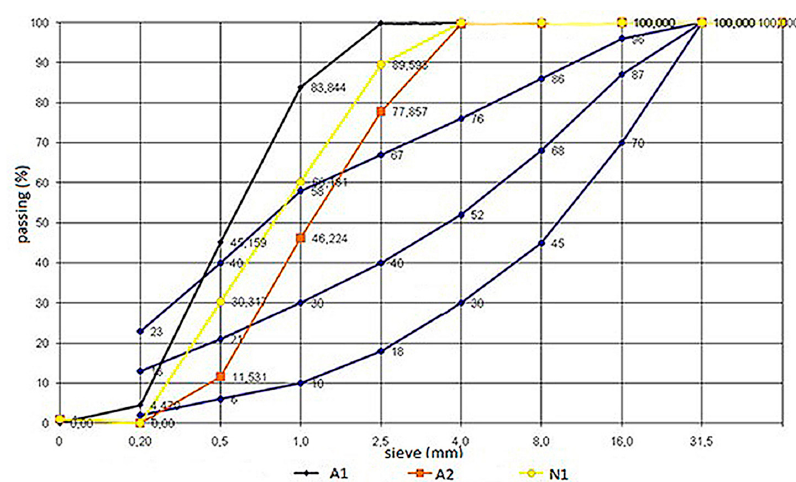
Figure 3. Gradation of the sands.